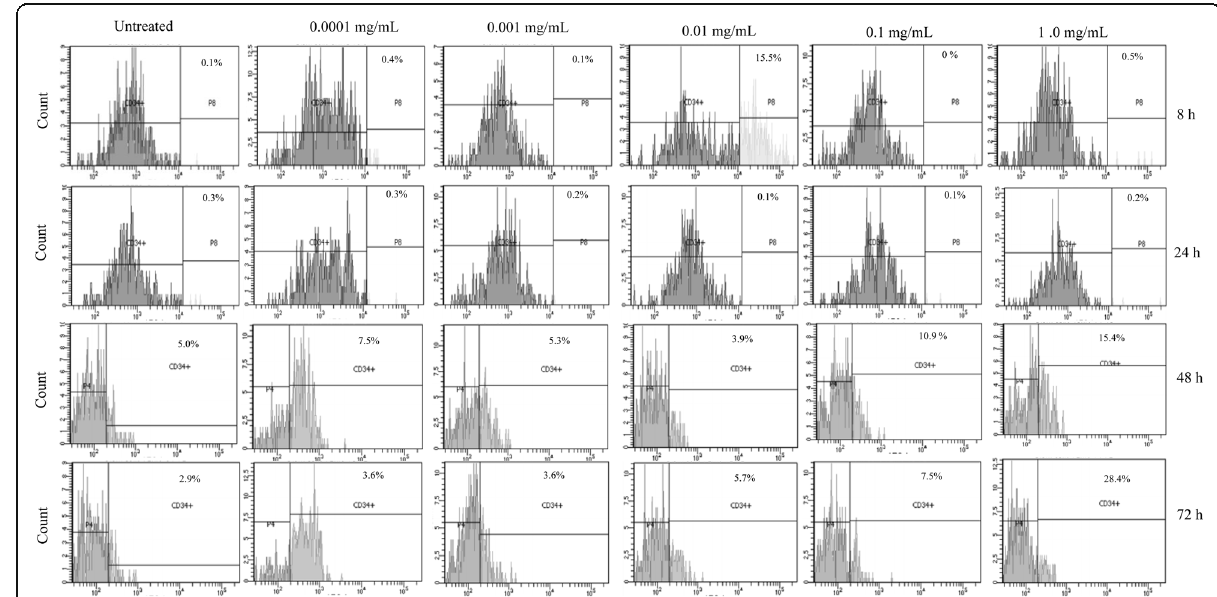
Fig. 4 In vitro CD34 expression stimulated by ‘ StemForte Plus® ’ by Flow Cytometry